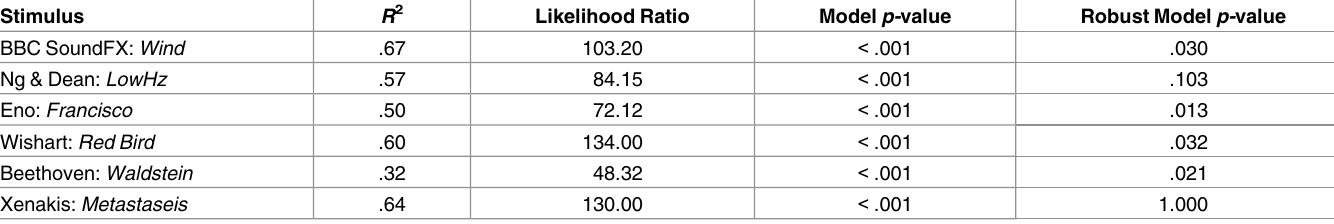
Table 6. Summaryof selected cox hazard models of perceived phrases using the whole-phrase global approach and additional spectral parameters. Stimulus R